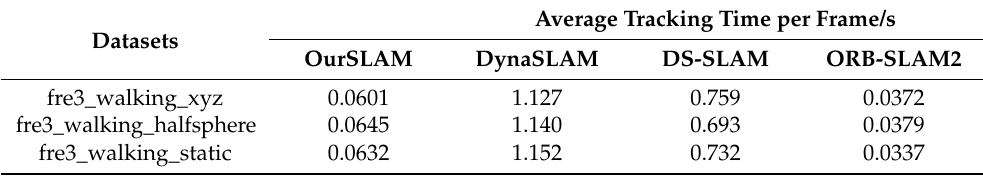
Table 3. Real-time comparison of SLAM algorithms in dynamic